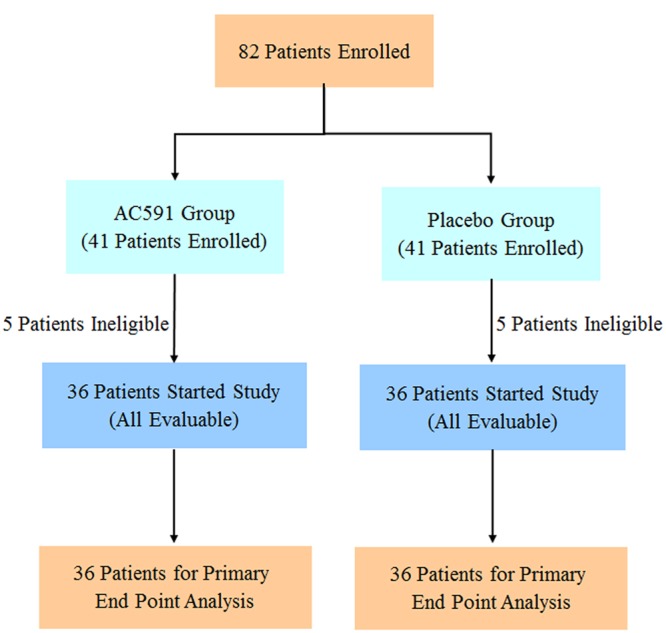
CONSORT statement flow diagram of patients included in the study.